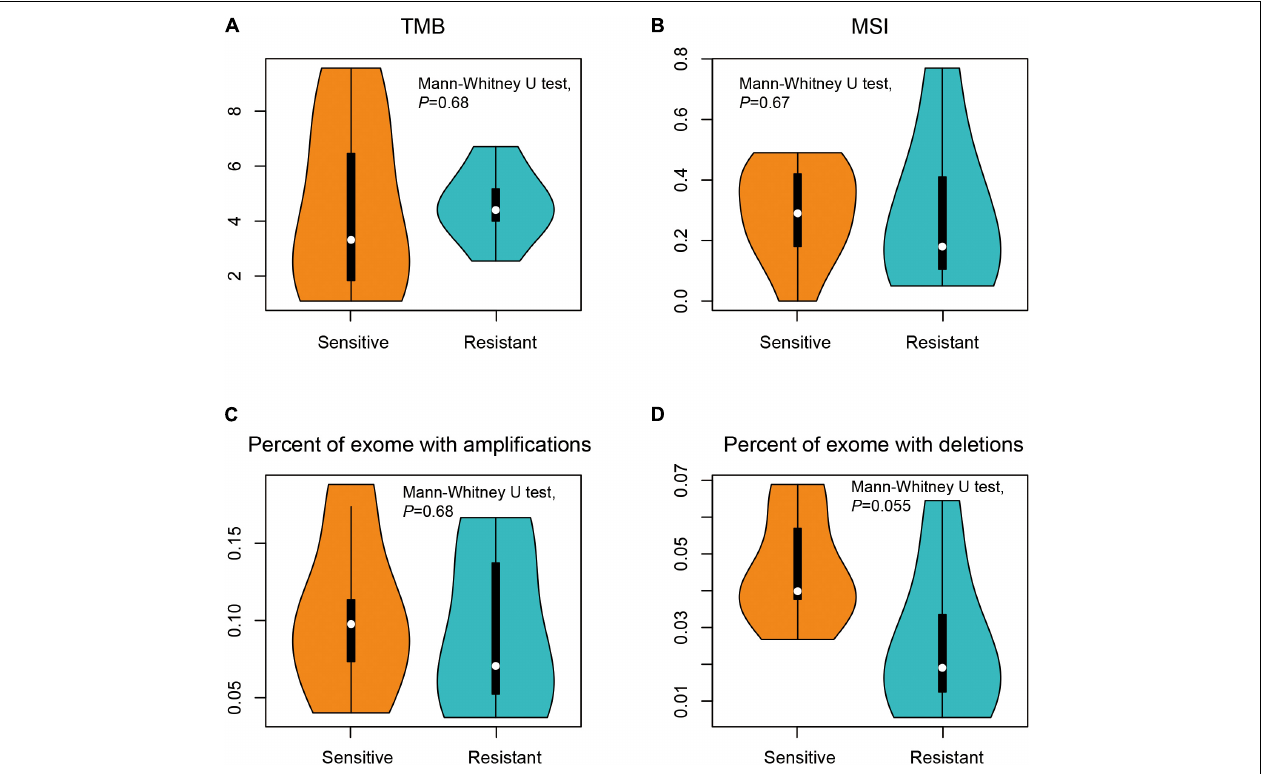
FIGURE 2 | Comparison of the genomic profiles between dicycloplatin-sensitive and dicycloplatin-resistant groups. (A) Tumor mutational burden (TMB). (B) Microsatellite instability (MSI) score. (C) Percentage of exons with amplification (defined as copy number ≥ 2 × average ploidy). (D) Percentage of exons with deletion (defined as copy number ≤ 0.5 × average